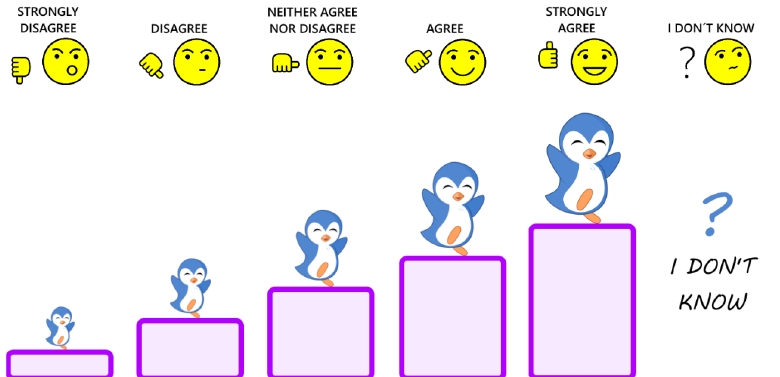
Figure 1. Labels of a) the Likert-type format (top), and b) the visual discrete format